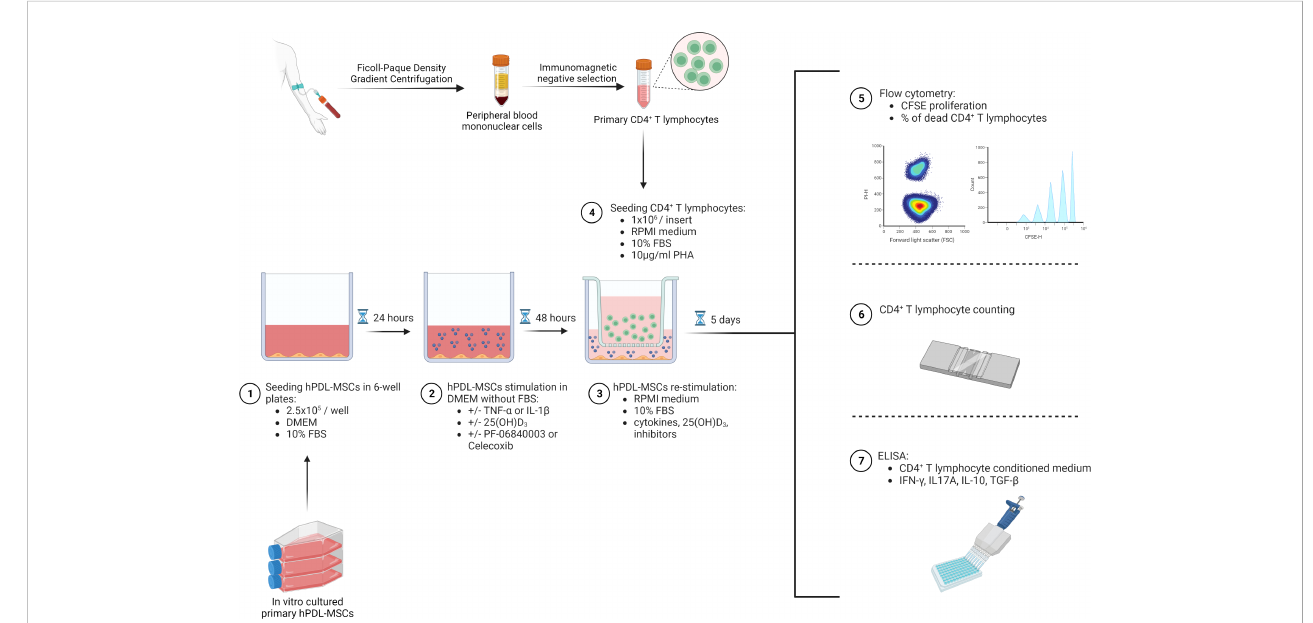
FIGURE 1 Graphical presentation and timeline of the indirect co-culture experimental setup. Created with